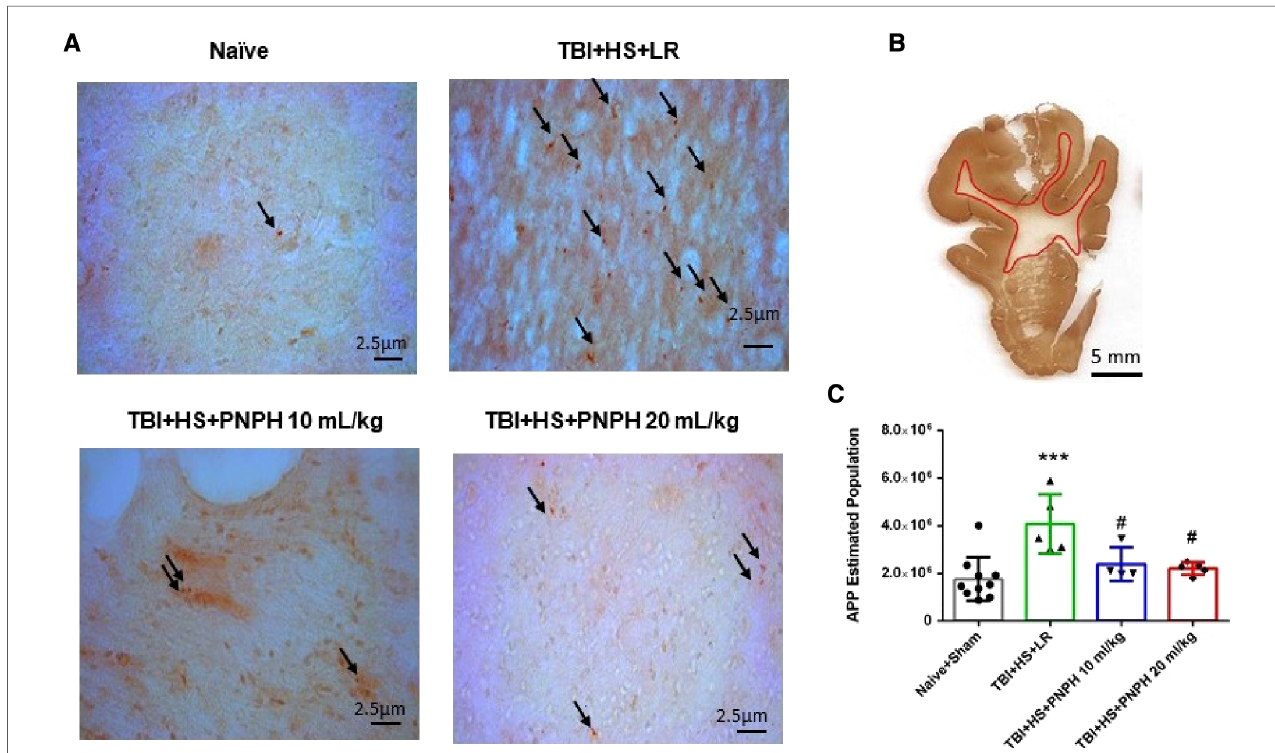
FIGURE 4 Effect of PNPH on amyloid precursor protein (APP) punctate accumulation after TBI+hemorrhagic shock (HS). ( A ) Representative images of APP immunostaining from naïve pig and TBI+HS pigs resuscitated with 60 ml/kg lactated Ringer ’ s (LR) solution or 10 ml/kg PNPH and 20 ml/kg PNPH. Arrows point to particles of APP accumulation. ( B ) The area of subcortical white used in the analysis is illustrated with the red trace. ( C ) The number of APP particles throughout subcortical white matter was estimated with the optical fractionator method of unbiased stereology and are plotted for the combined Naïve+Sham group ( n =10) and for TBI+HS groups resuscitated with 60 ml/kg LR ( n =5), 10 ml/kg PNPH ( n =4), and 20 ml/kg PNPH ( n =5). Both doses of PNPH blunted the increase in APP particles seen in the LR group. Mean±SD and individual data for each pig are shown. *** P <0.001 vs. combined Naïve+Sham group. # P <0.05 vs. LR group determined by one-way ANOVA and the Holm-Sidak procedure for multiple